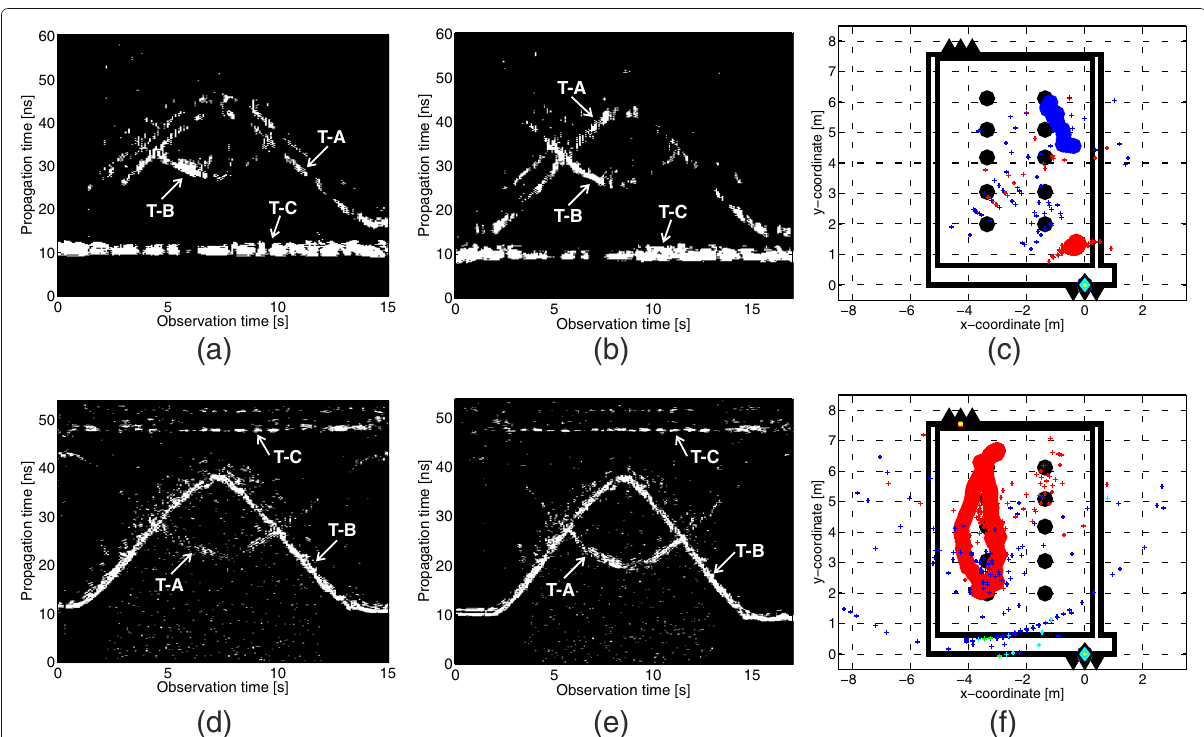
Fig. 6 Illustration of the impact of static shielding (scenario 2). Detection, localization ( plussign symbols) and tracking results obtained by the sensor S1: a detector output for Rx 1,1 , b detector output for Rx 1,2 and c final target tracks. Detection, localization ( plussign symbols) and tracking results obtained by the sensor S2: d detector output for Rx 2,1 , e detector output for Rx 2,2 and f final target tracks